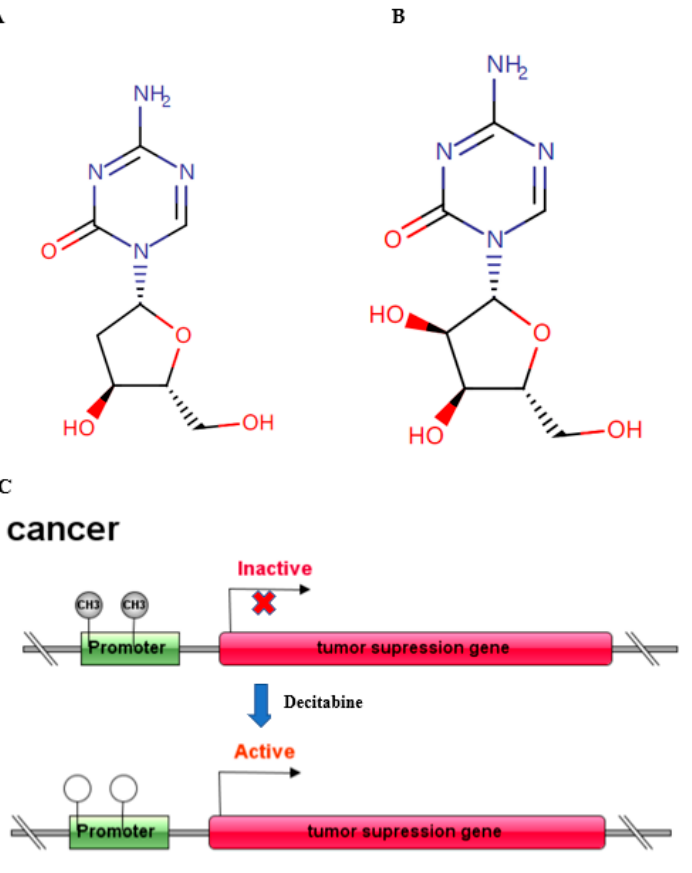
Figure 1. Molecular structure of decitabine ( A ) and 5-azacytidine; ( B ) schematic diagram of antitumor mechanism ( C ).